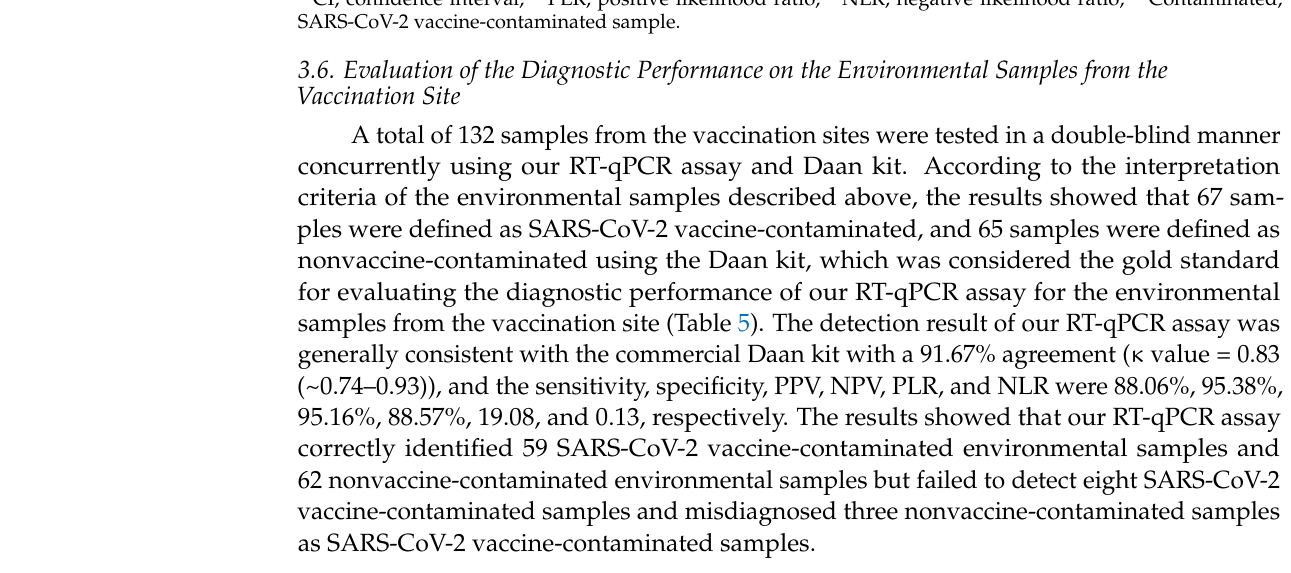
Table 5. The diagnostic performance of our RT-qPCR assay on 132 environmental samples from vaccination